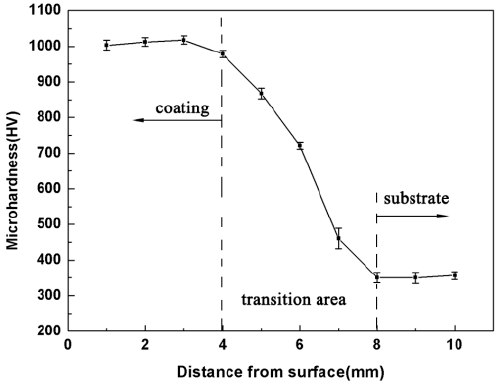
Figure 13. The microhardness profile from the top of the coating to the substrate.